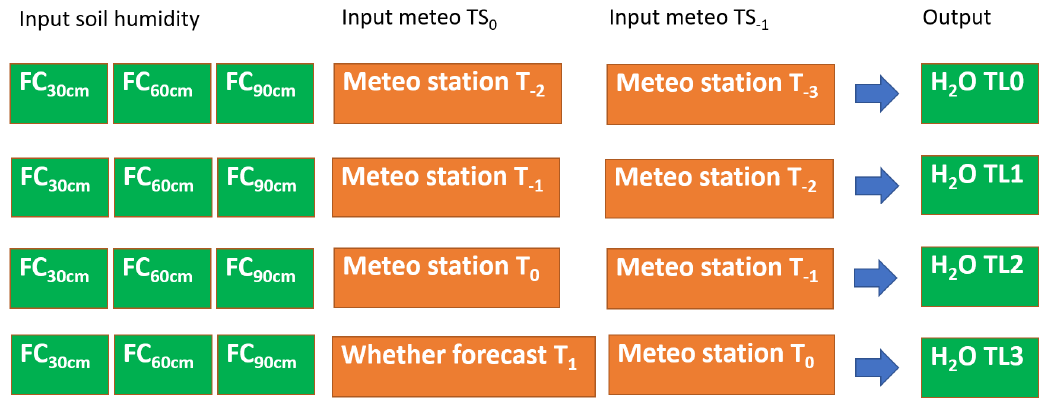
Figure 8. Time-lag, time-series (TS) approach scheme in the application phase; soil moisture at different depths (30, 60, and 90 cm) was substituted with the field capacity at the same depth. The output is represented by the irrigation water forecasted from 0 (TL0; present date) to 3 (TL3) days after.